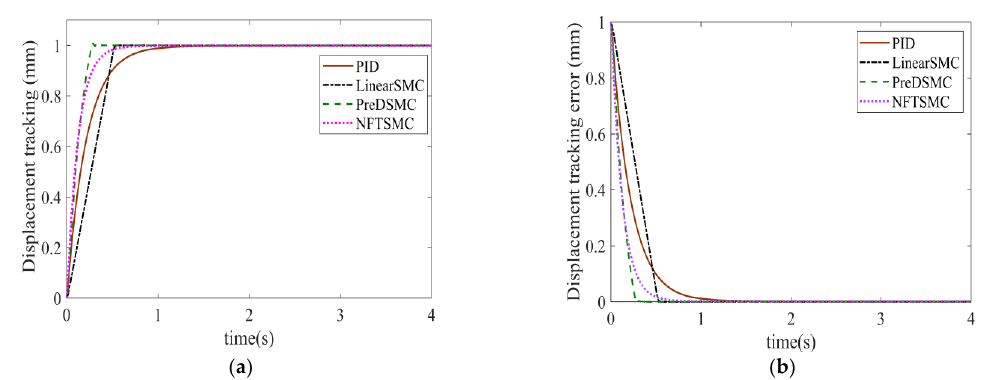
Figure 3. ( a ) Comparative step tracking performance of displacement for all control laws. ( b ) The corresponding step tracking error of displacement.